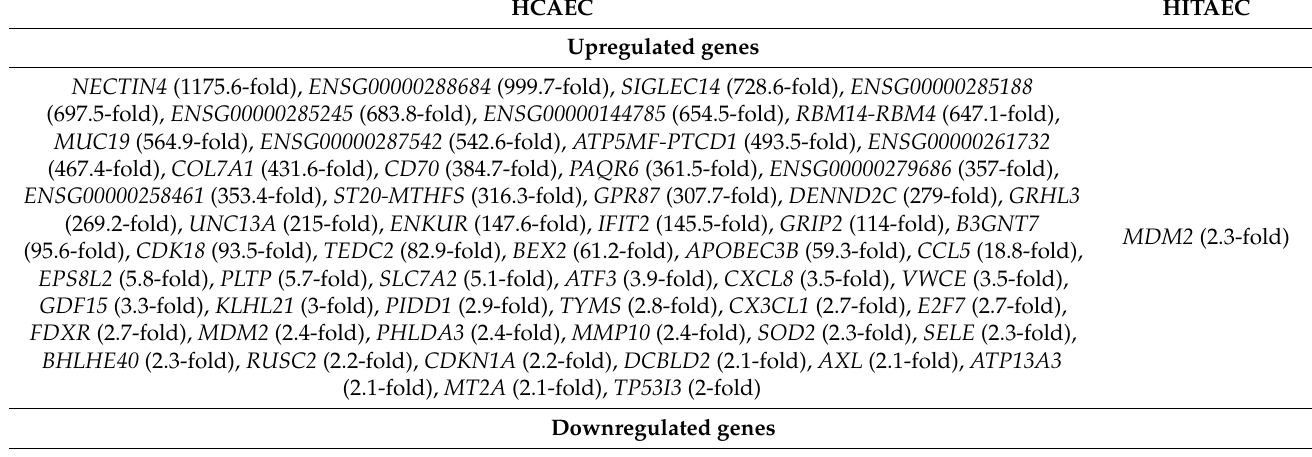
Table 1. The differentially expressed genes (DEGs) identified in Human Coronary Artery Endothelial Cells (HCAEC) and Human Internal Thoracic Endothelial Cells (HITAEC) exposed to mitomycin C (MMC) in comparison with the non-exposed control after applying the cut-off criterion (FDR p -value < 0.05, absolute fold change ≥